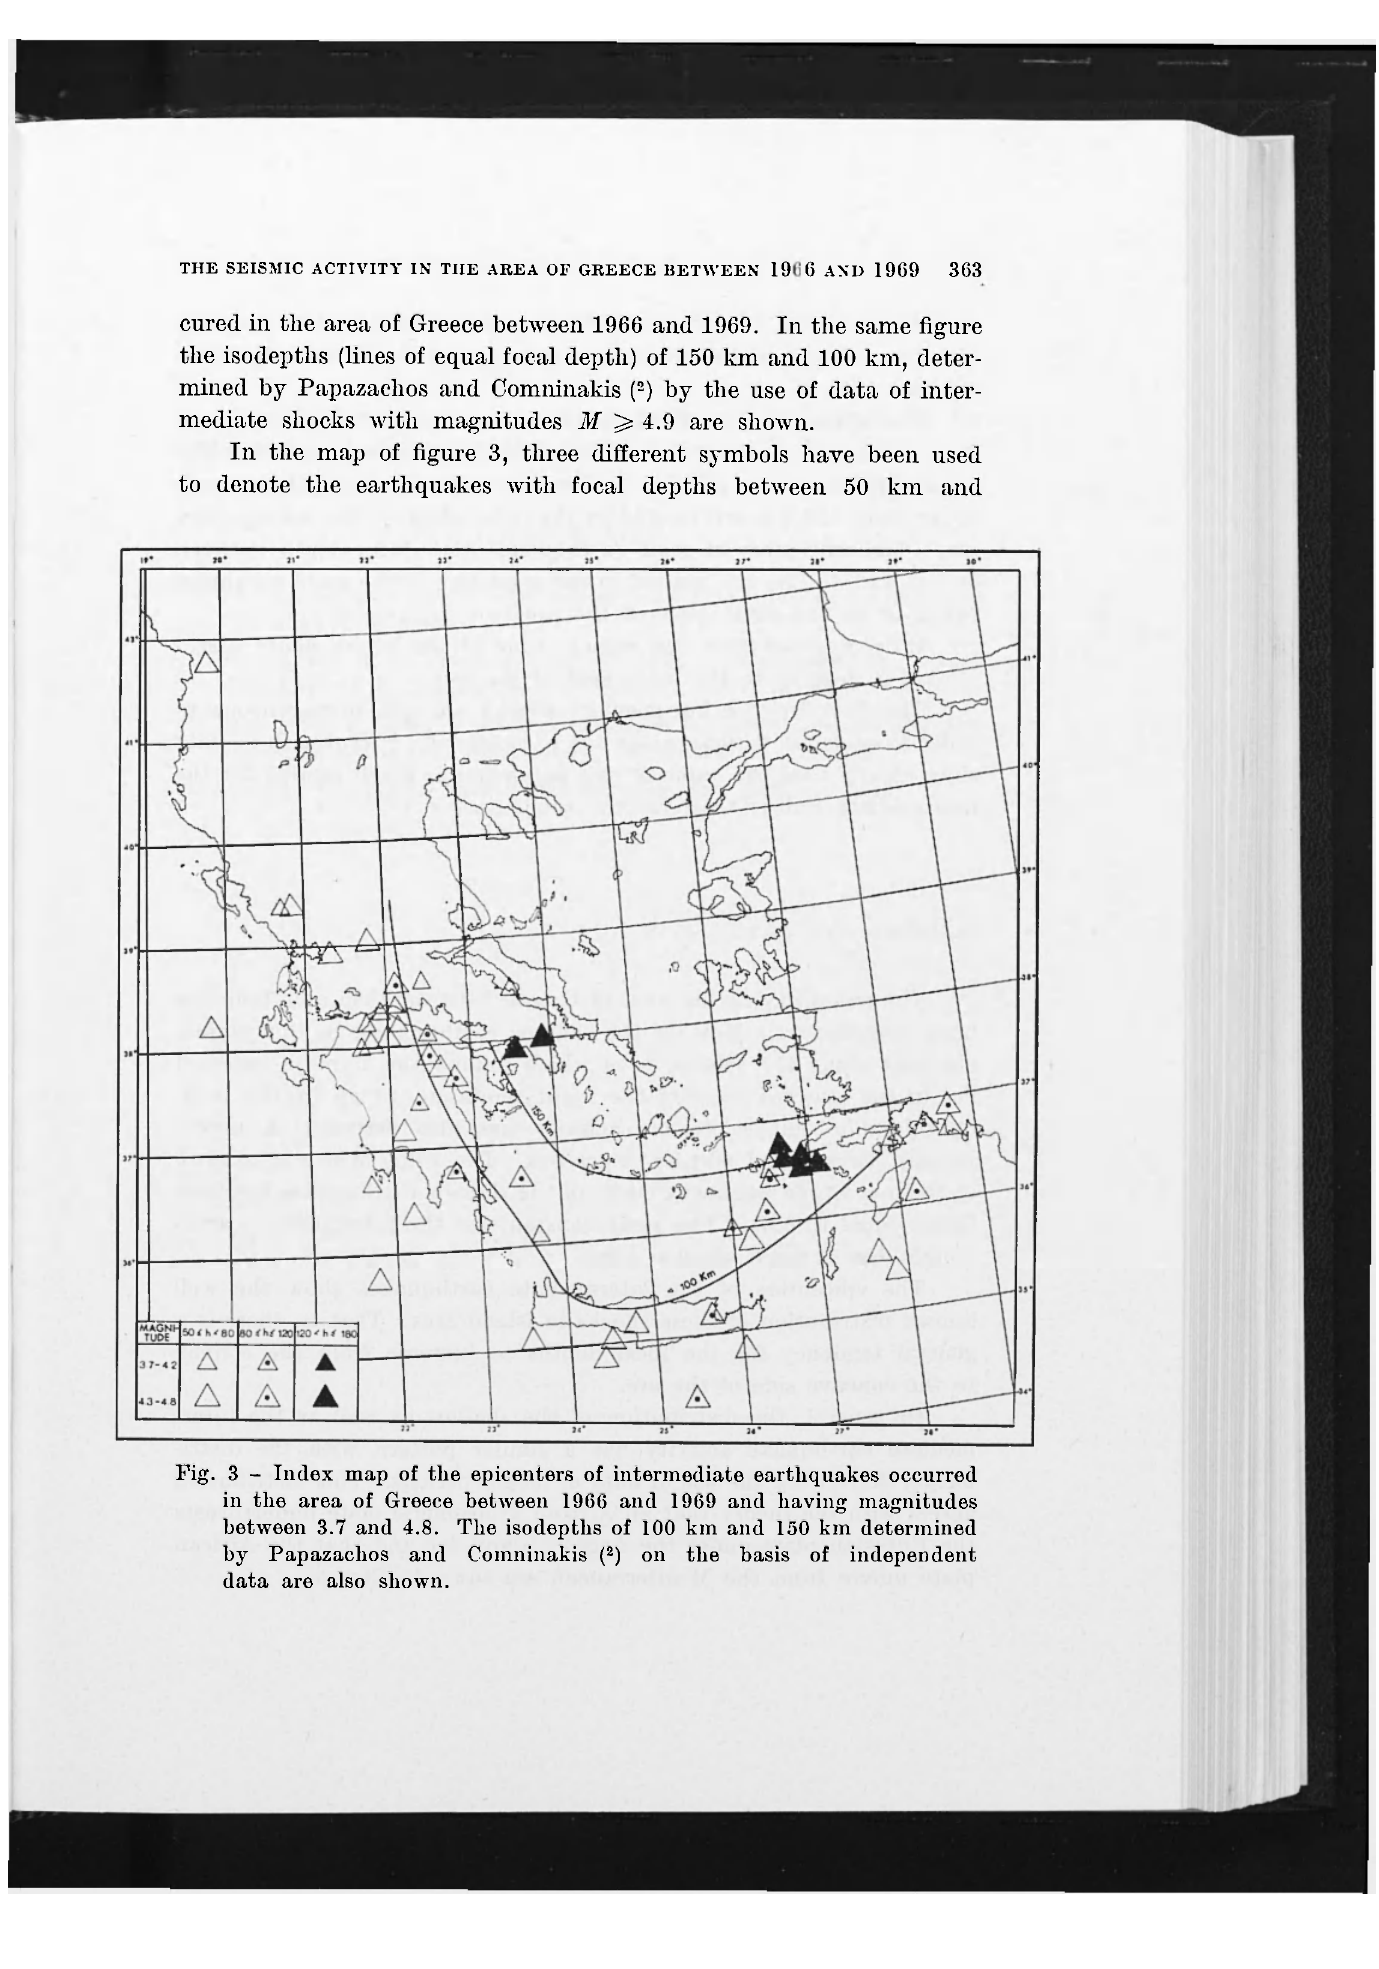
Fig. 3 - Index map of the epicenters of intermediate earthquakes occurred in the area of Greece between 1966 and 1969 and having magnitudes between 3.7 and 4.8. The isodepths of 100 km and 150 km determined by Papazachos and Comninakis ( 2 ) on the basis of independent data are also